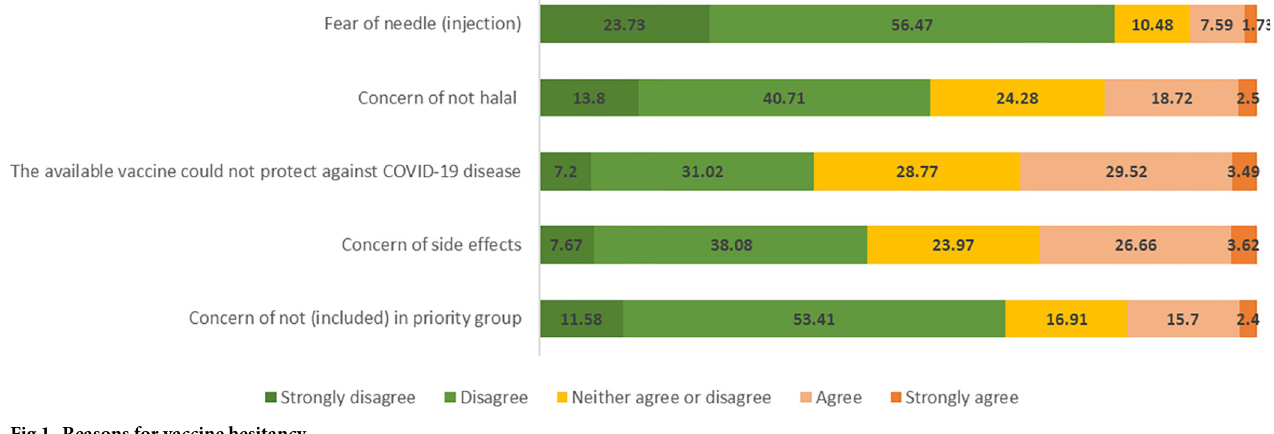
Fig 1. Reasons for vaccine